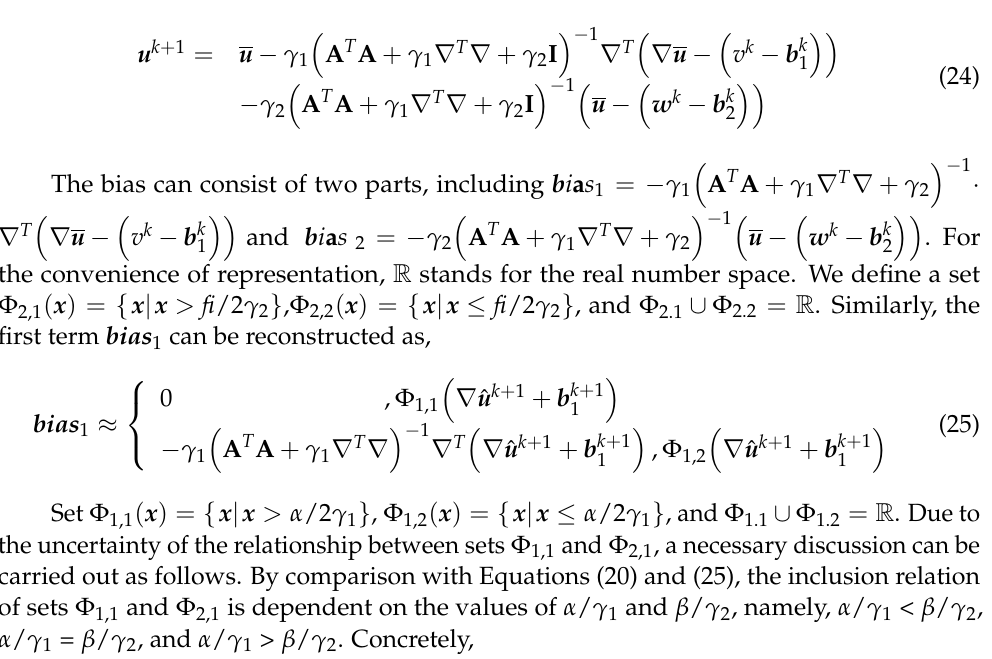
when α / γ 1 = fi / γ 2 , i.e., Φ 2,1 = Φ 1,1 and Φ 1,2 = Φ 2,2 . The partially bias-corrected